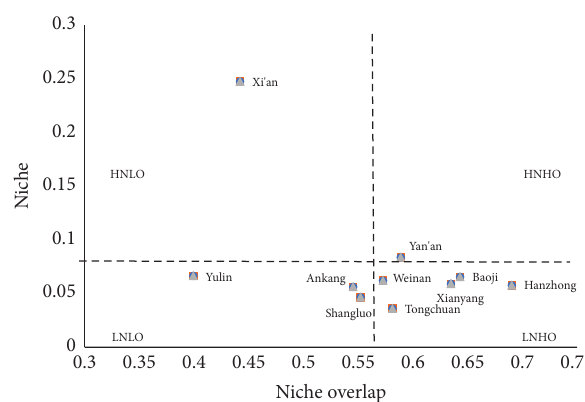
Figure 1: Overall distribution of tourism niche in Shaanxi.